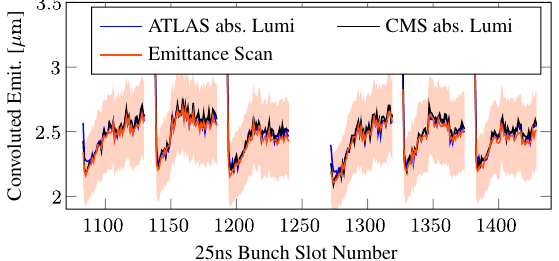
FIG. 13. Bunch-by-bunch convoluted emittances for 6 typical bunch trains (LHC fill 6054). The shaded error region for the emittance scan data includes both systematic and statistical uncertainties.